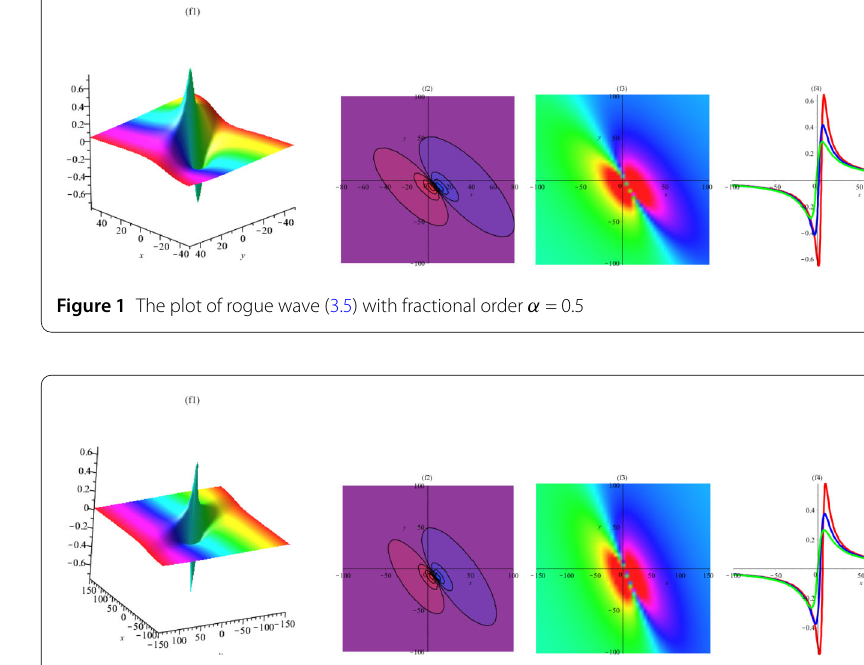
Figure 2 The plot of rogue wave (3.5) with fractional order α = 0.8